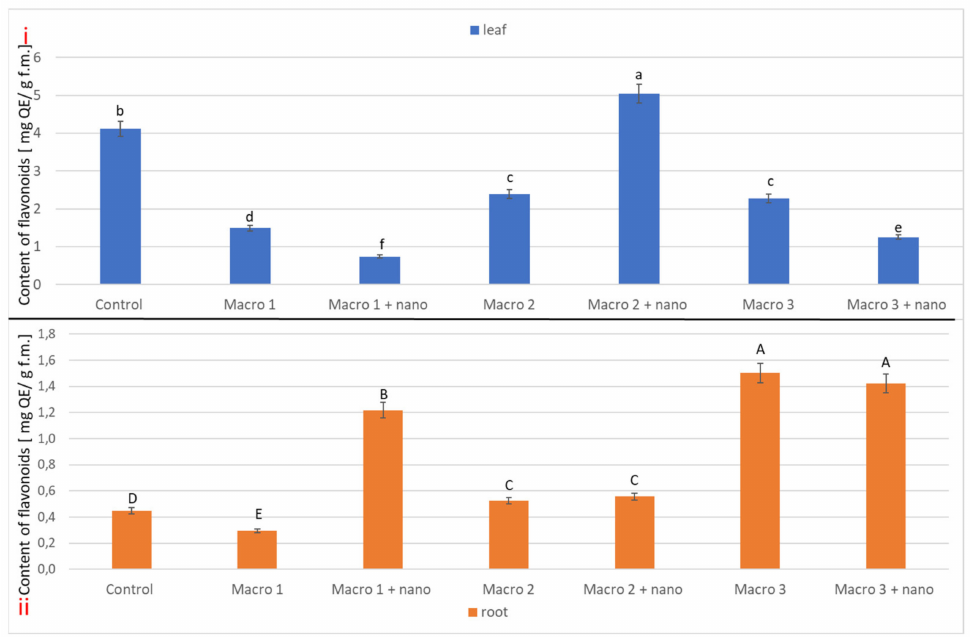
Figure 4. The content of flavonoids [mg QE g − 1 fresh weight] in the shoots ( i ) and roots ( ii ) of plants grown in soil supplemented macronutrients or macronutrients and nanoparticles. Vertical bars represent the mean values (n = 5) ± standard deviations. Different letters indicate significant difference at p < 0.05 by LSD